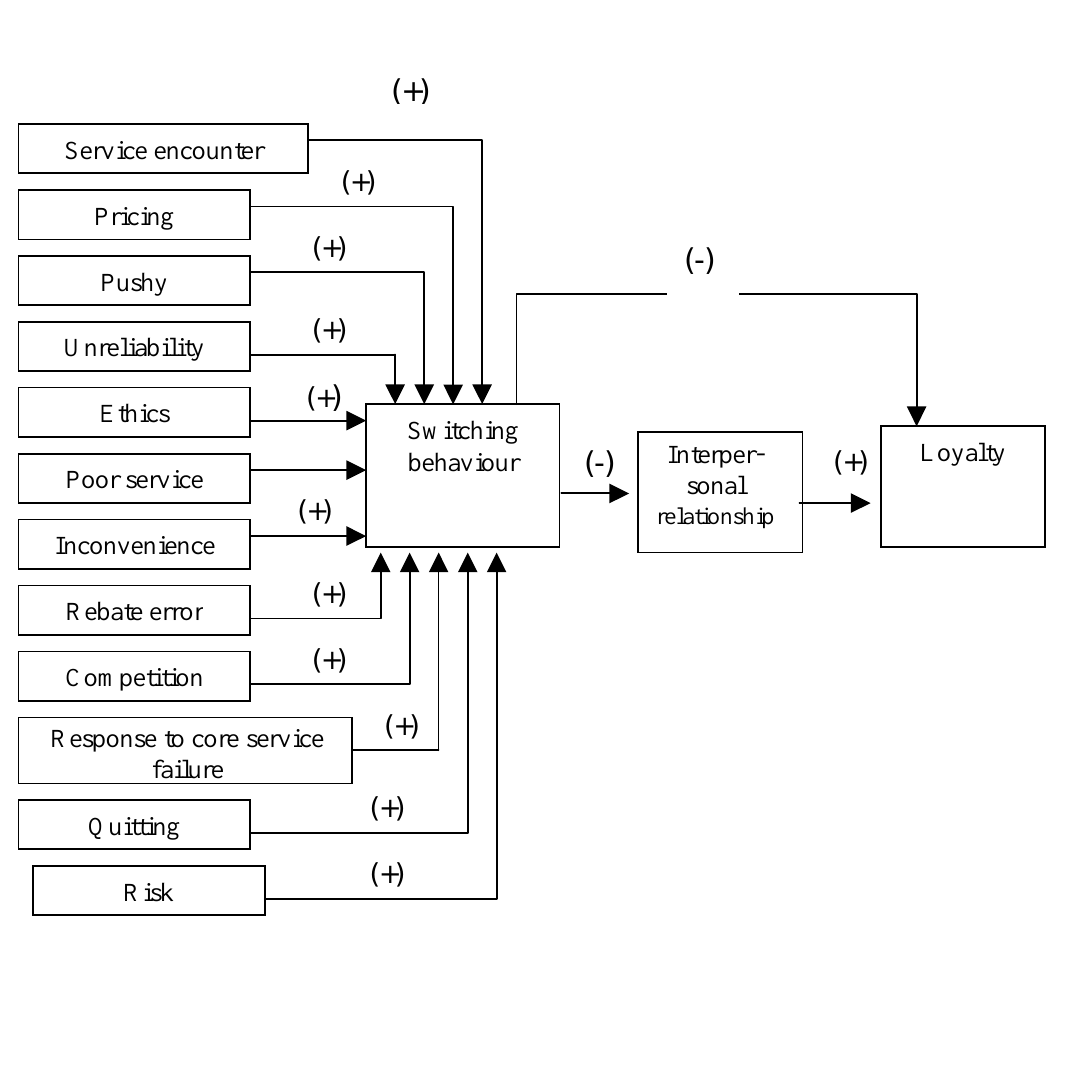
Figure 1 Proposed switching behaviour